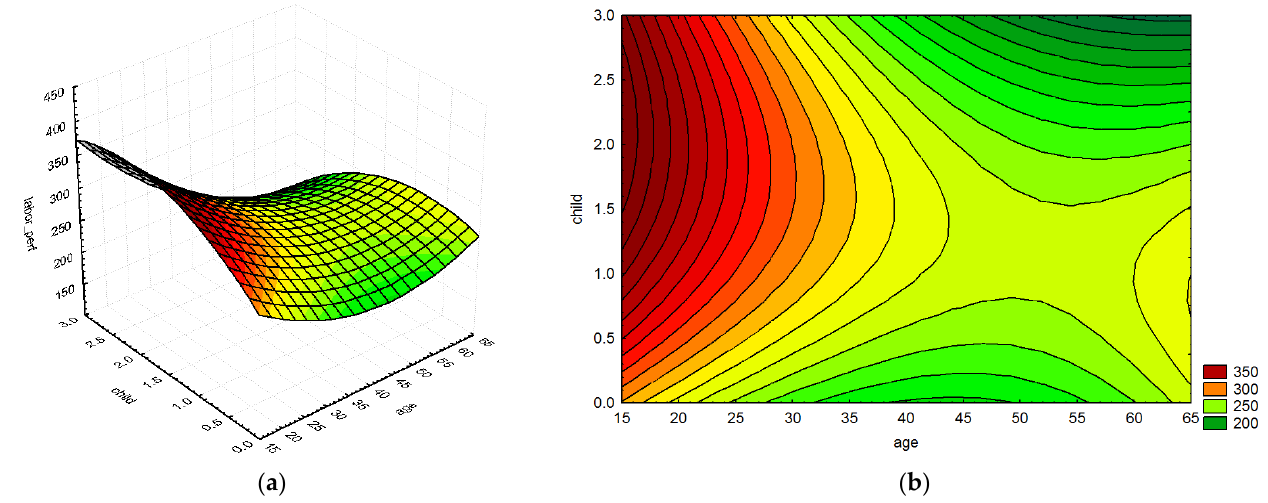
Figure 3. 3D surface plots ( a ) and contour plots ( b ) for the variable “labor_perf” depending on variables “age” and “child”.